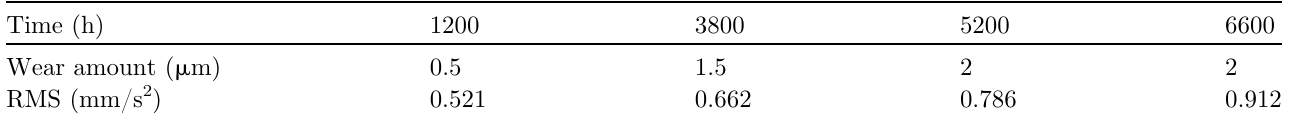
Table 4. The wear amount and RMS values of experiments Exp6 ( P m and n m ∼ Exp5) with lubrication. Time (h)